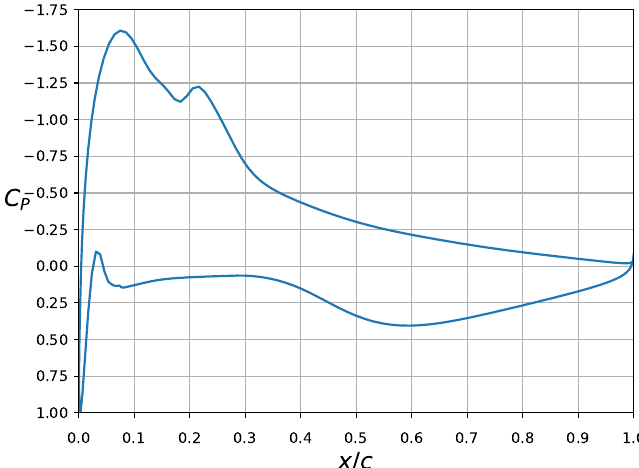
Figure 13. Chordwise C P distribution at the symmetry plane for Re = 10 5 and α = 6 ◦ .